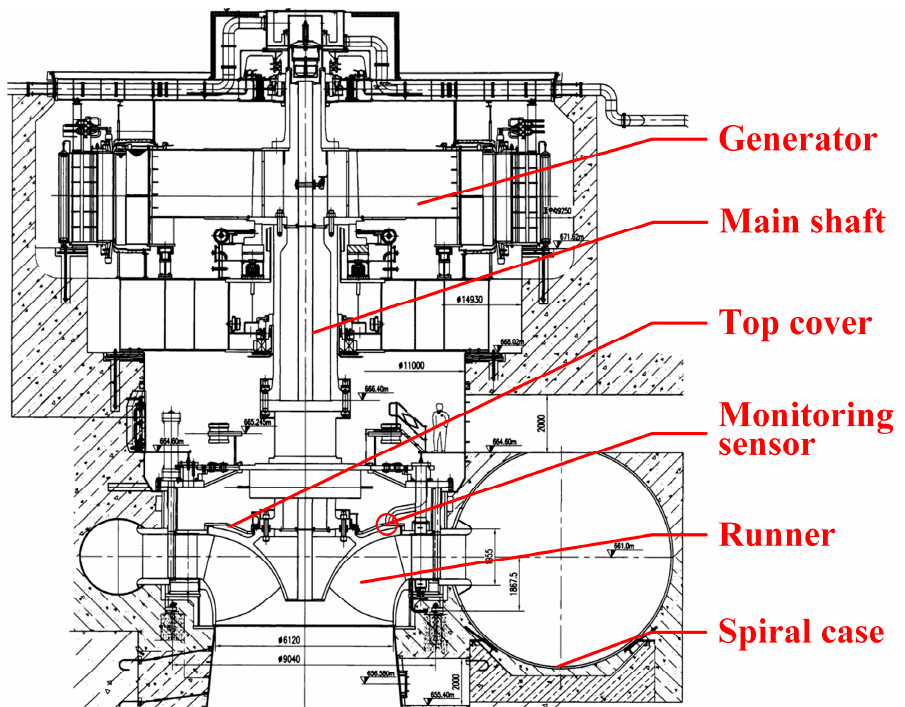
Figure 7. The position of the monitoring sensor.